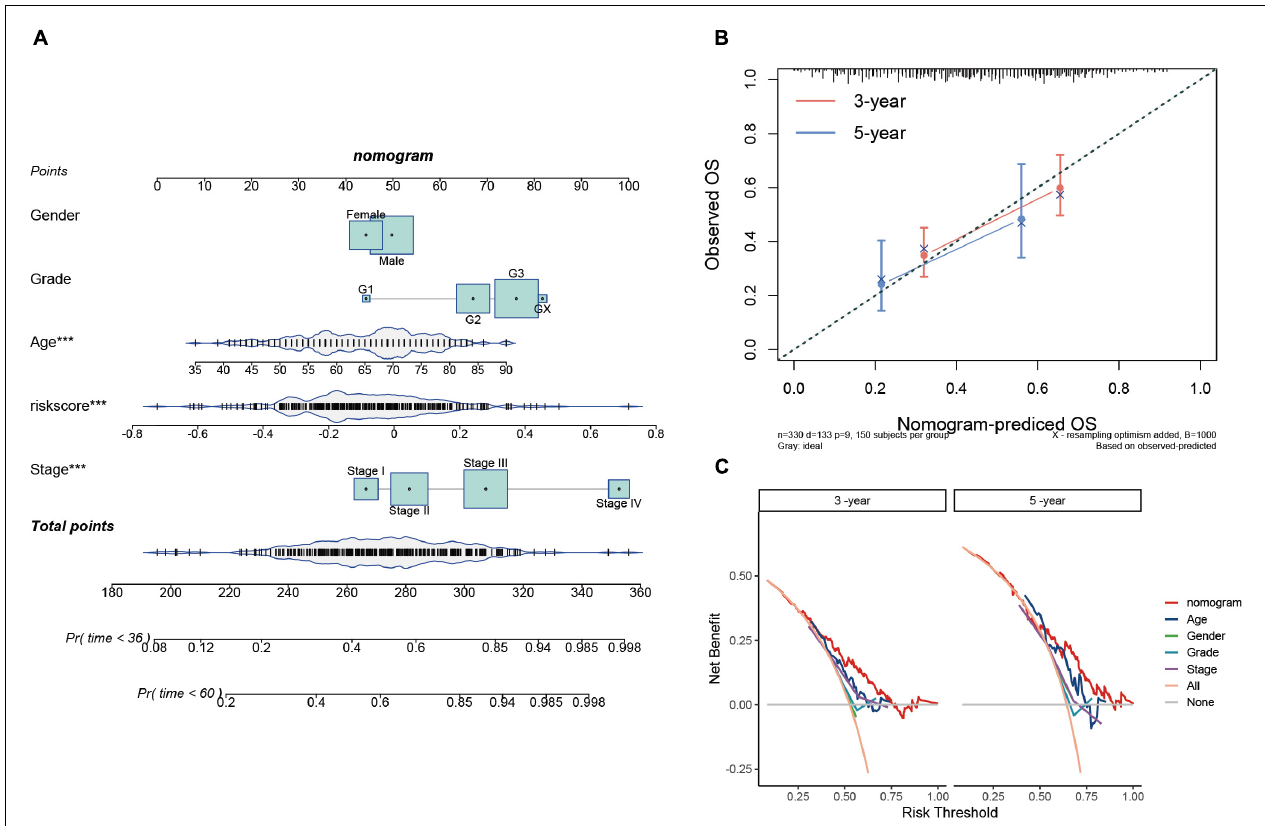
FIGURE 7 | Construction and validation of the prognostic nomogram. (A) Nomogram for 3- and 5-year survival predictions. (B) Calibration curves for validating the accuracy of the 3- and 5-year survival predictions. (C) DCA analyses of the nomogram and clinical features at two different time